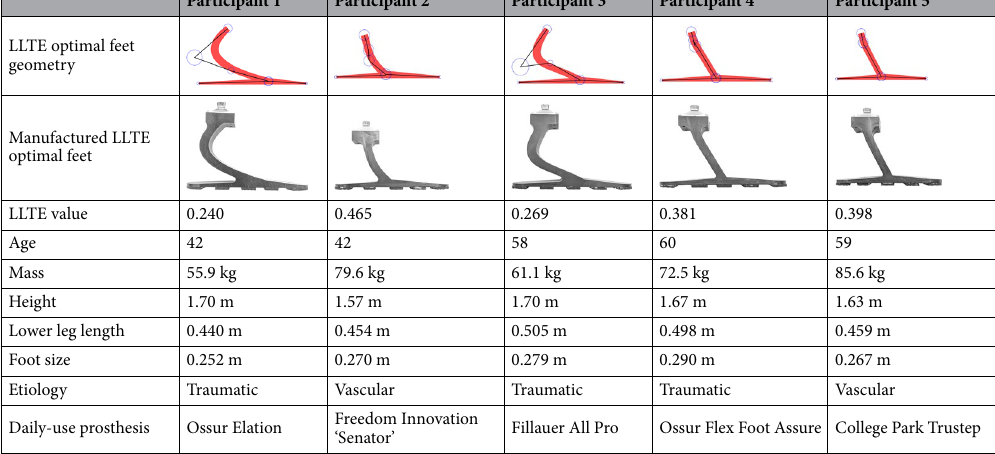
Table 1. Recruited participants’ characteristics, the corresponding prosthetic foot designed and customized using the LLTE framework, and their daily-use prosthetic foot